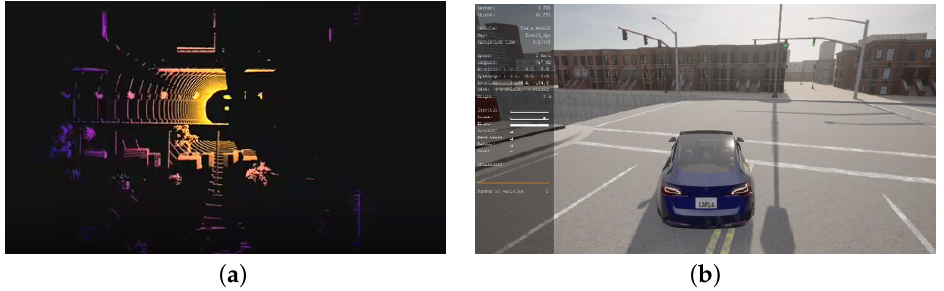
Figure 3. CARLA simulator presents by LiDAR information and 3D visualization. ( a ) The LIDAR information. ( b ) Third person visualization.